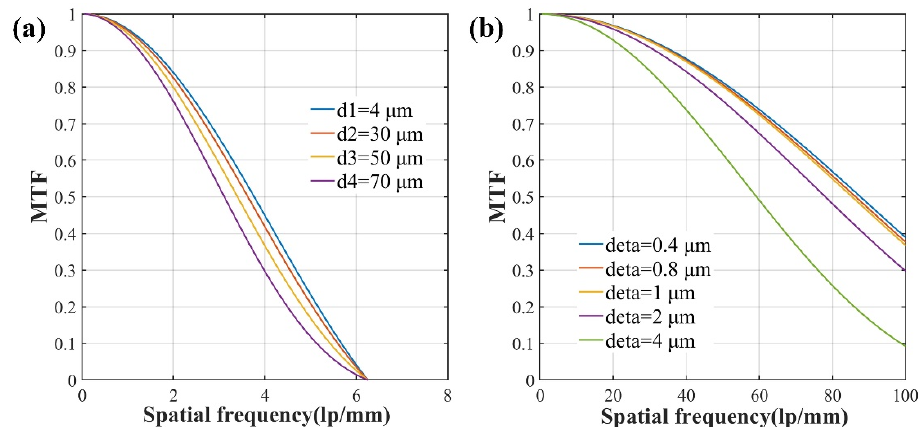
Figure 2. The dependences of modulation transfer function ( MTF fib ) on ( a ) core diameter and ( b ) scanning step.